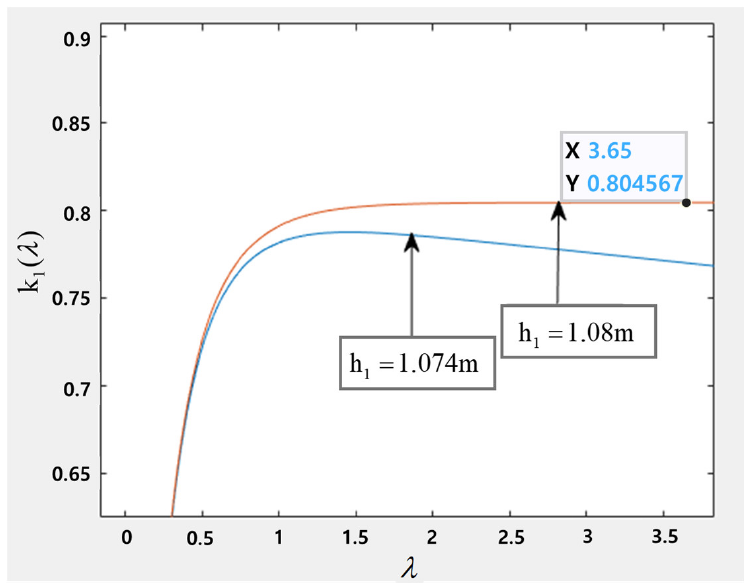
Figure 10.   (λ) according to the different ℎ